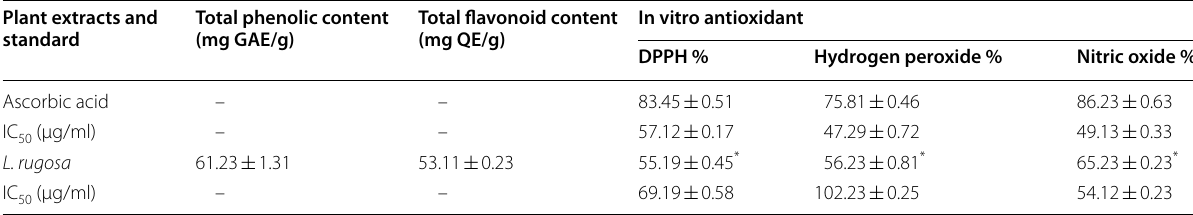
Table 2 Determination of total phenolic, flavonoid content, in vitro antioxidant activity and corresponding IC extract of L. rugosa